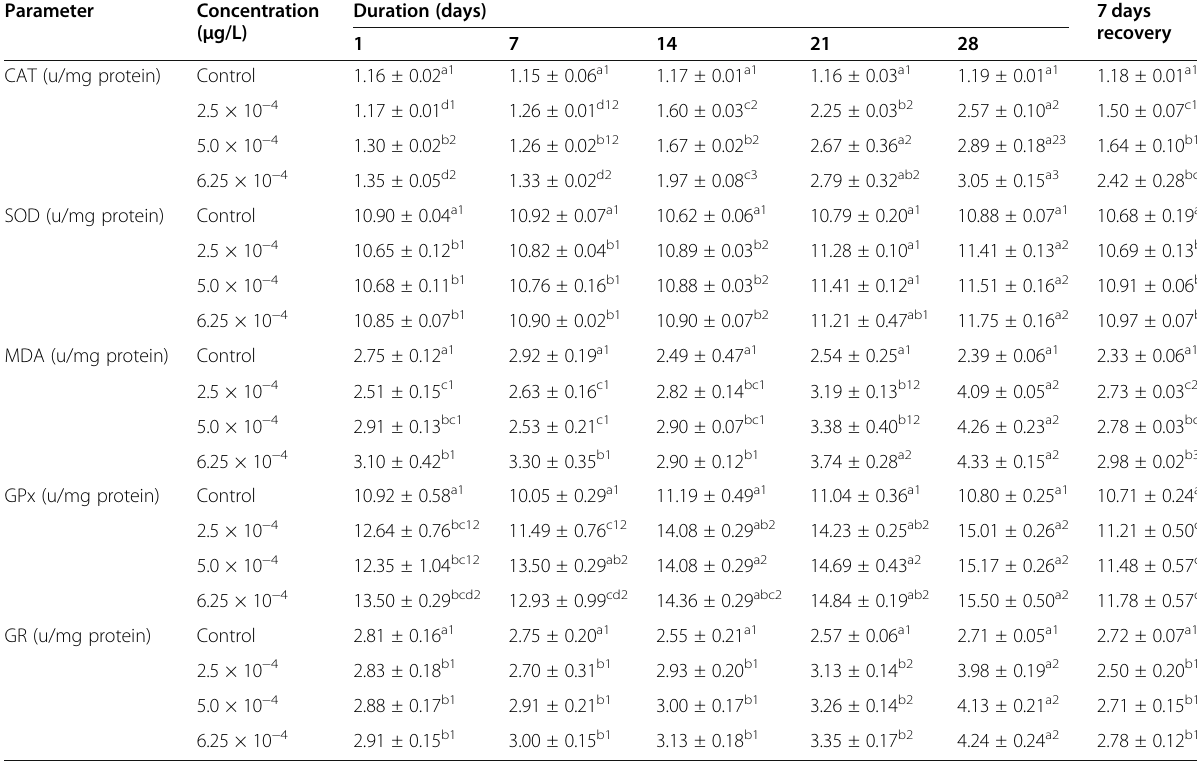
Table 1 Effects of lambda-cyhalothrin on oxidative stress biomarkers